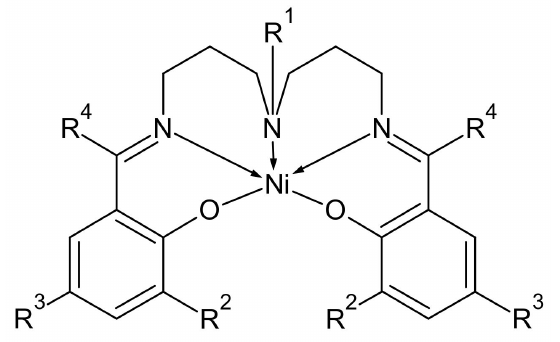
Figure 7. Schematic representations of pentacoordinate Ni(II) complexes. 1 : R 1 = R 3 = − CH 3 ,